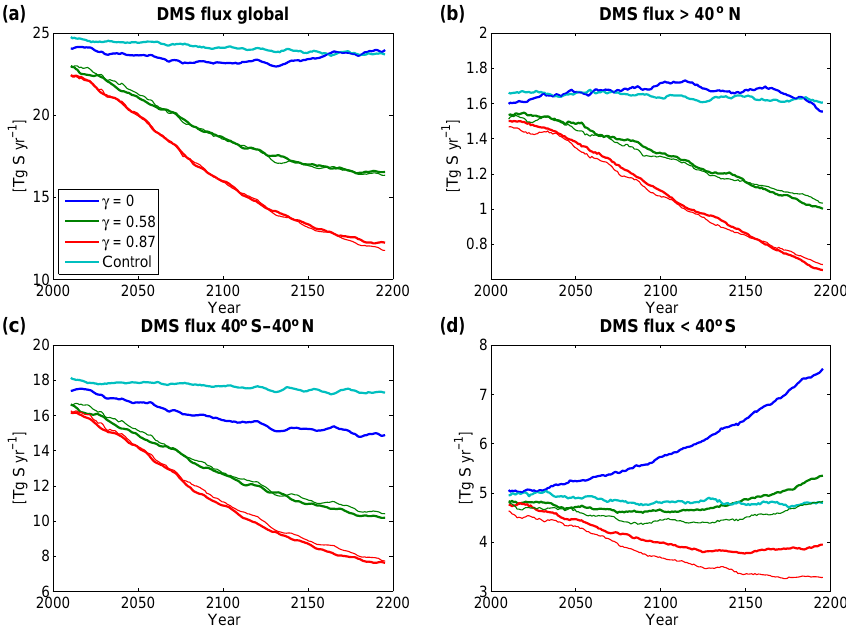
Figure 10. Time series of DMS fluxes (smoothed by a 10-year running mean filter) for the RCP8.5 scenario and its extension to 2200 for the experiments BASE (dark blue lines), SMED (green) and SHIGH (red). The control run fluxes are indicated by the light blue lines. Thin green and red lines give an estimate of the fluxes that would occur without DMS–climate feedback ( F ∗